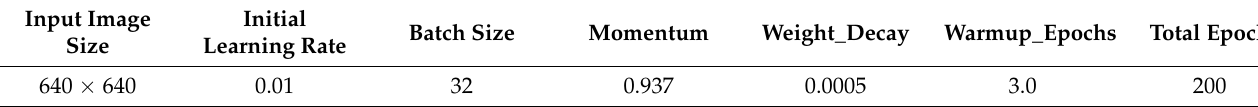
Table 2. Initial parameters of the